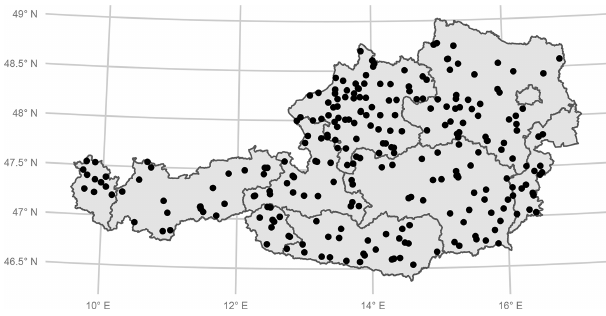
Figure 1. Overview of the 260 gauging stations used in the study.